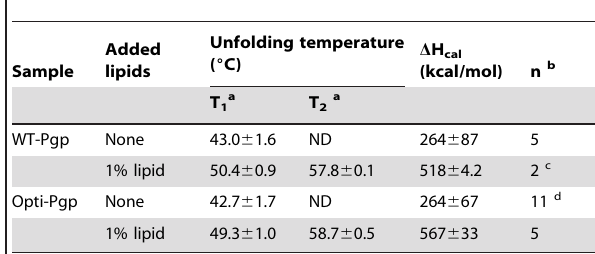
Table 2. Thermal unfolding parameters of WT- and Opti-Pgp.